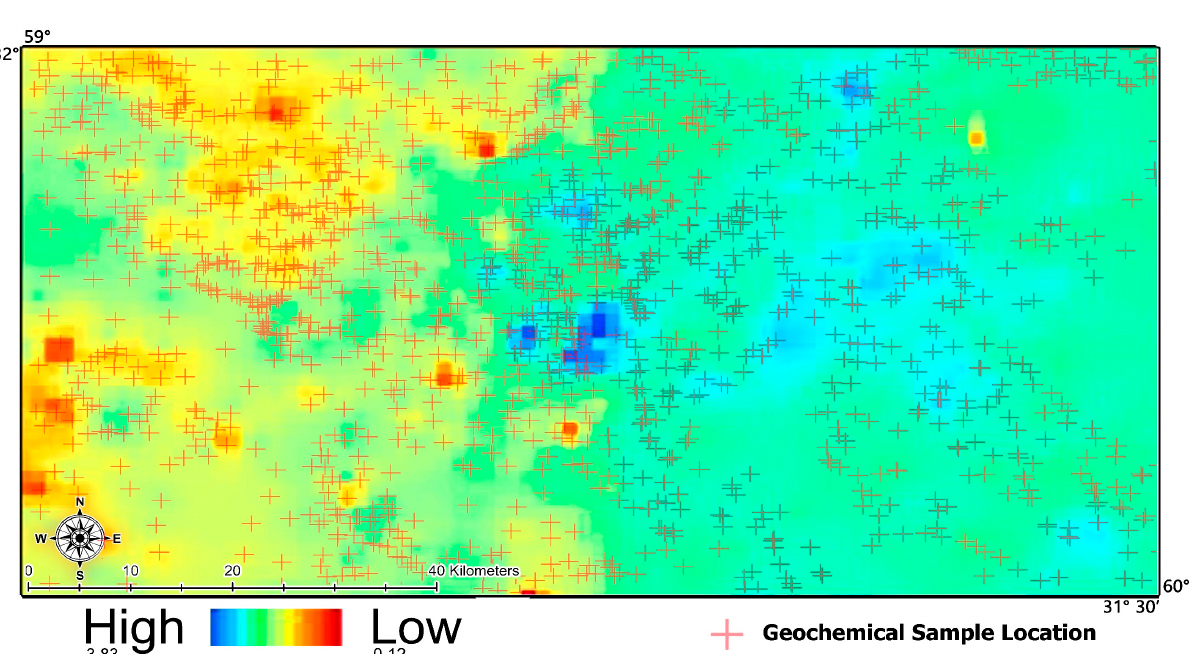
Figure 20. Hierarchical diagram of the fuzzy-AHP hybrid method and criteria and sub-criteria con- sidered in decision making. Each criterion and sub-criterion considered in the integration process should be weighted. This weighting is based on expert opinions supported by many metallic studies